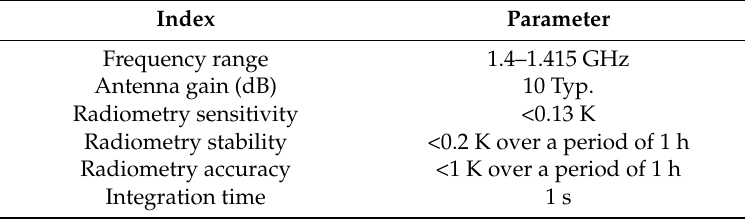
Table 1. Instrument specifications of the developed L-band radiometer.